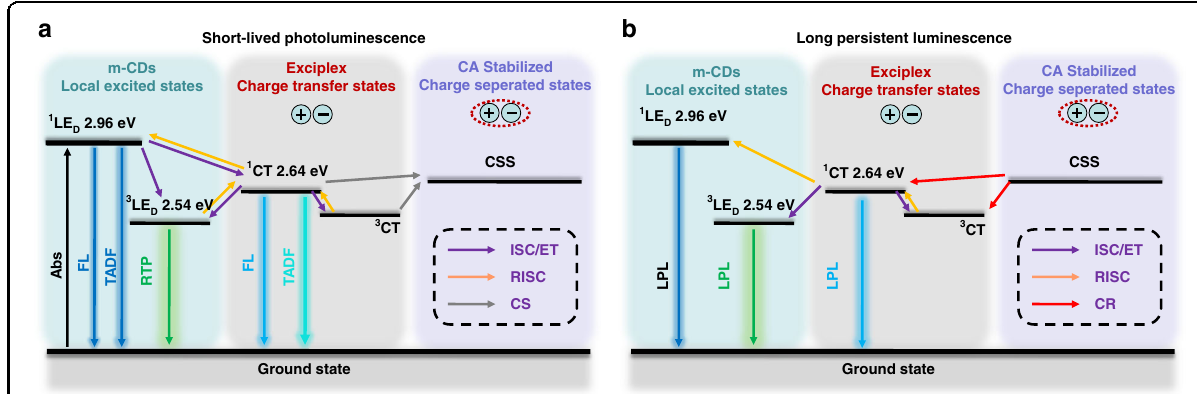
Fig. 5 A proposed emission mechanism of m-CDs@CA a , b The emission mechanism before (i.e., short-lived PL including FL, RTP and TADF) and after recombination of CS states of exciplex (i.e., LPL) of m-CDs@CA under the UV light (365 nm) irradiation. The energy levels were calculated based on the onsets of the corresponding emission spectra. Electron donor (D, i.e., m-CDs), acceptor (A, i.e., CA), absorption (Abs), fl uorescence (FL), charge transfer (CT, i.e., exciplex), electron transfer (ET), charge – separated states (CSS), charge separation (CS), charge recombination (CR), thermally activated delayed fl uorescence (TADF), room temperature phosphorescence (RTP), and long persistent luminescence